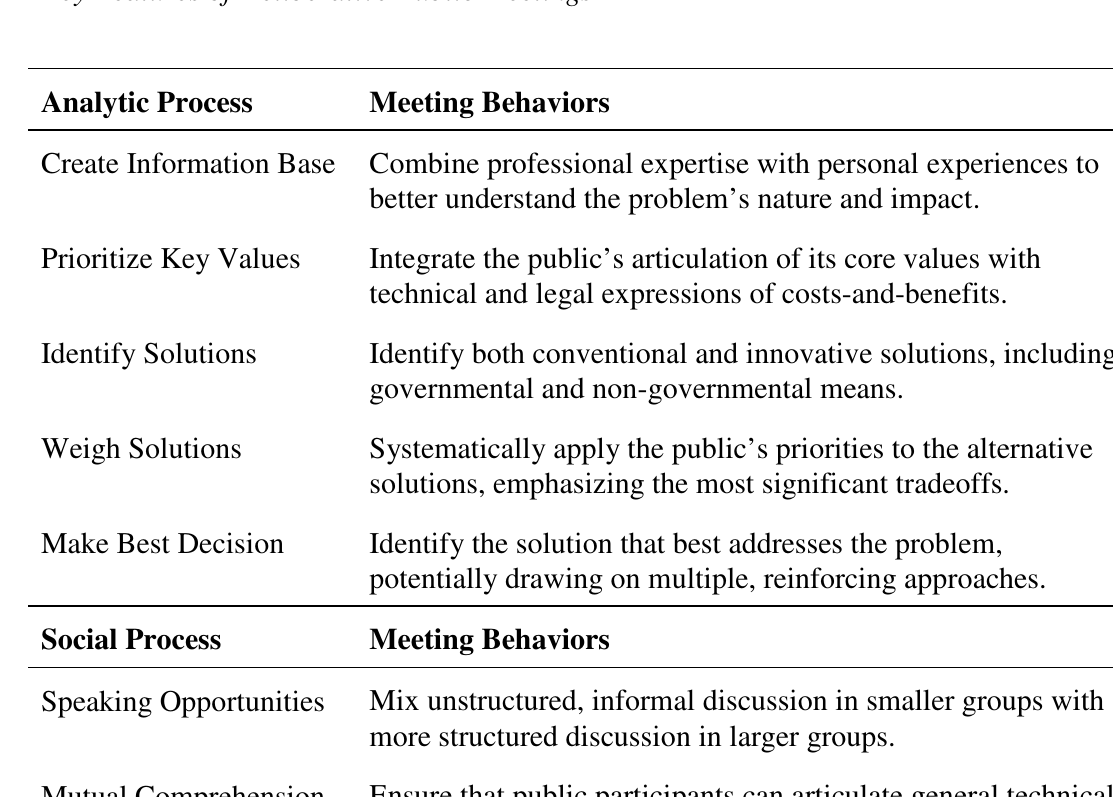
Table 6 Key Features of Deliberative Public